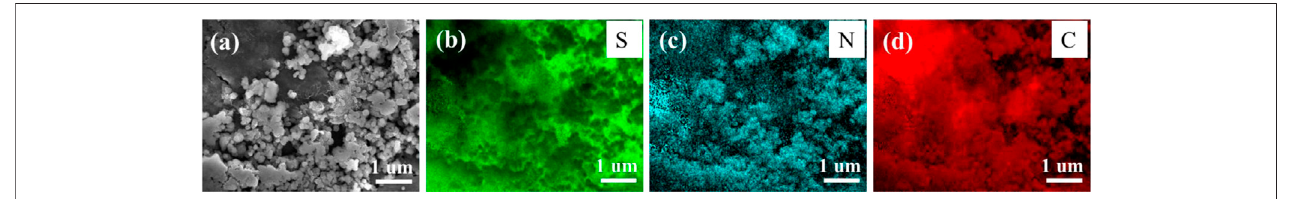
FIGURE 2 | (A) SEM-EDS image of S/PAN/KB composite, (B) sulfur, (C) nitrogen, and (D) carbon mapping of the composite.